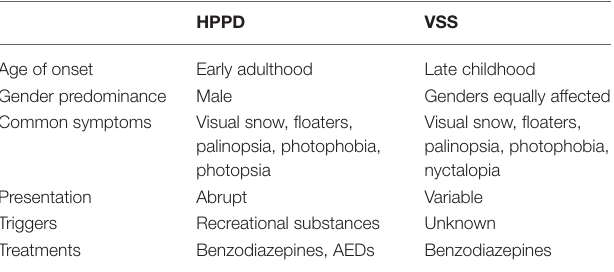
TABLE 6 | Comparison of HPPD and VSS clinical